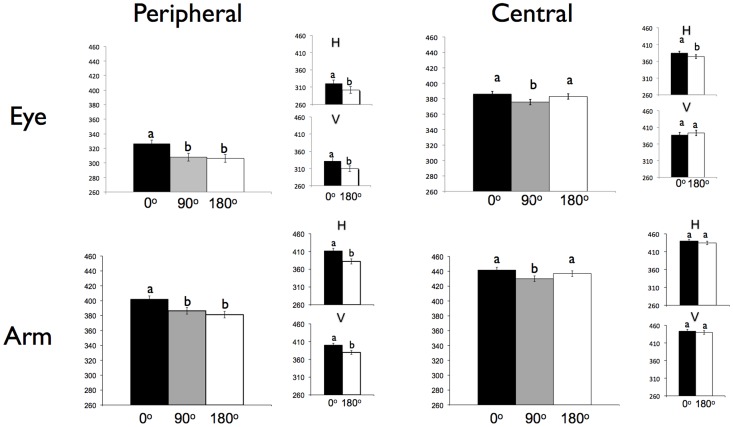
Reaction Times.Mean saccadic reaction times to the second signal (S2) for Experiments 1–4 are presented on the Y axis with RTs for each offset condition (0°, 90°, and 180°) presented as separate bars. Experiment 1 (Peripheral – Eye) is shown in the upper left; Experiment 2 (Central - Eye) is shown in the upper right; Experiment 3 (Peripheral - Arm) is show in the lower left; Experiment 4 (Central - Arm) is shown in the lower right. Conditions labelled with different letters (a, b, or c) are significantly different from each other. Error bars show within-subjects 95% confidence intervals, as described by Masson [41] using the Offset x Subject MSE term. H stands for horizontal axis; V stands for vertical axis.